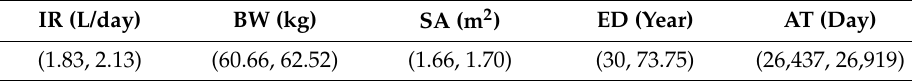
Table 2. Exposure parameters treated by α